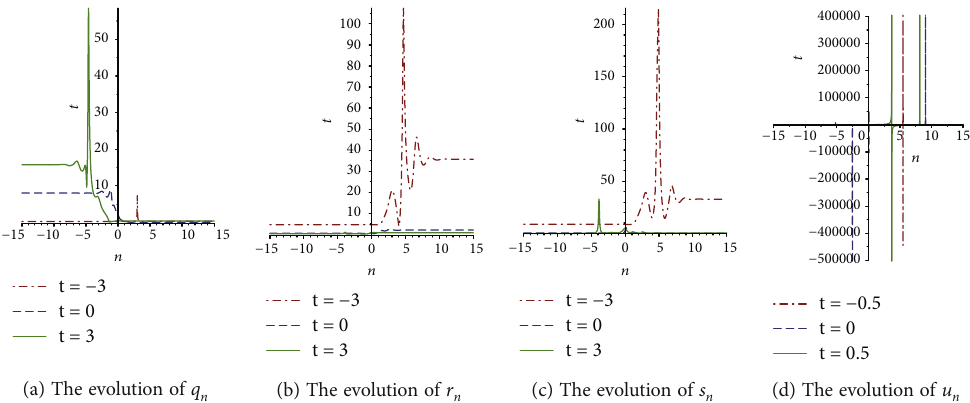
ffiffiffi p ffiffiffi p 3 2 and evolution of solution ~ u I , and κ 2 =